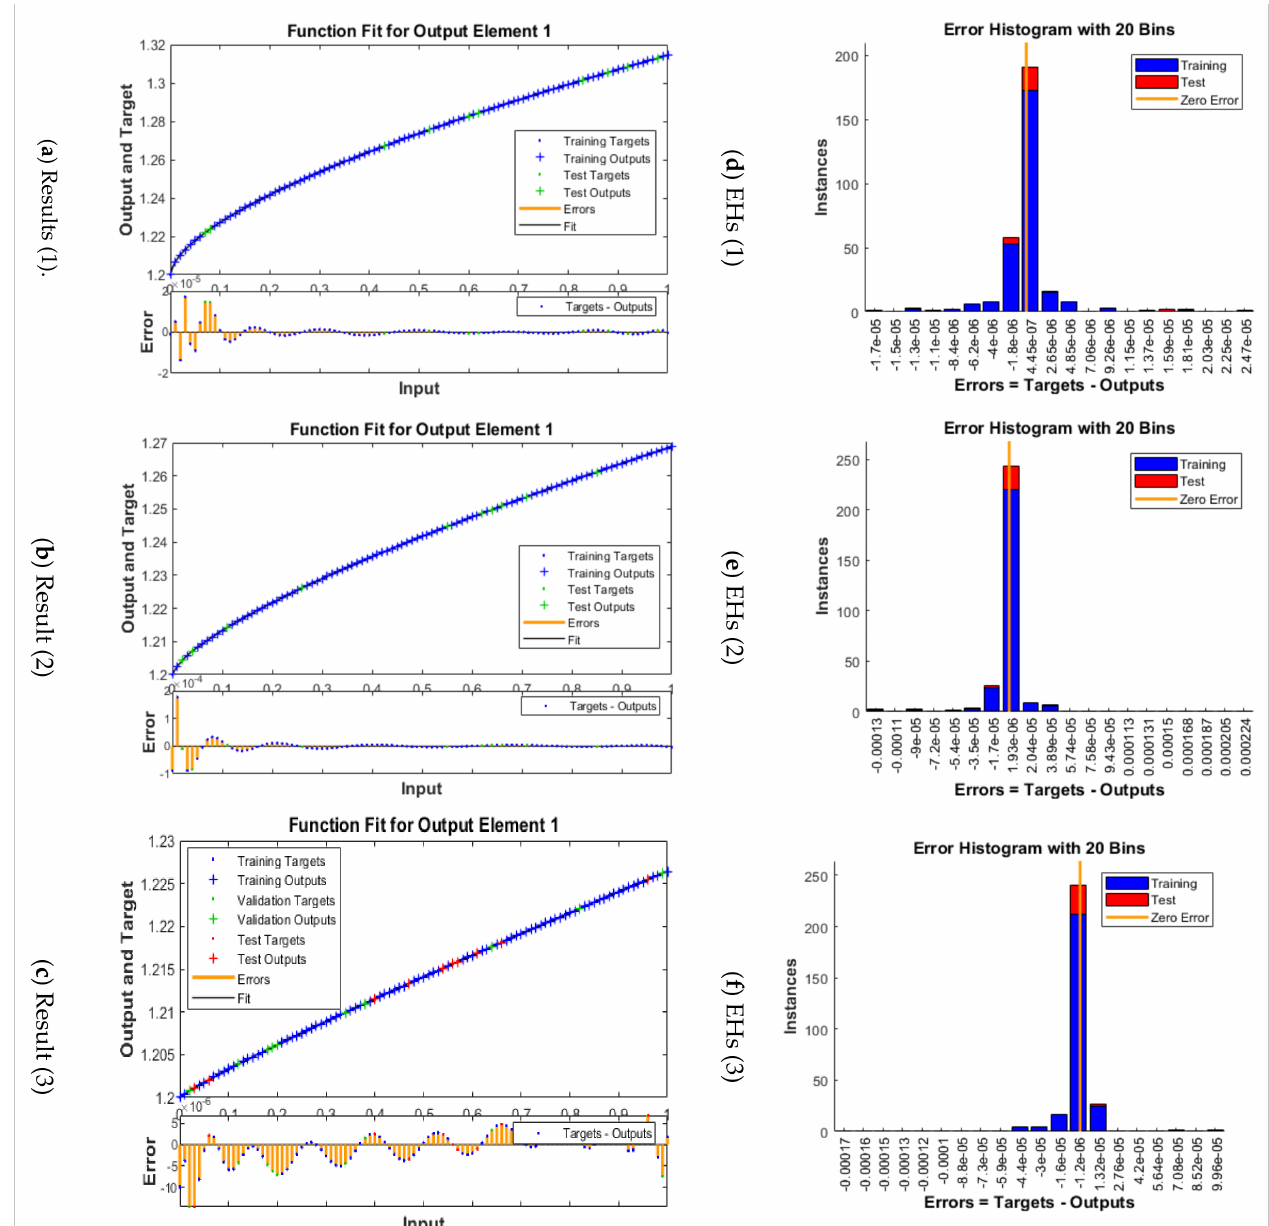
Figure 4. Results estimations and EHs measures for the dynamical